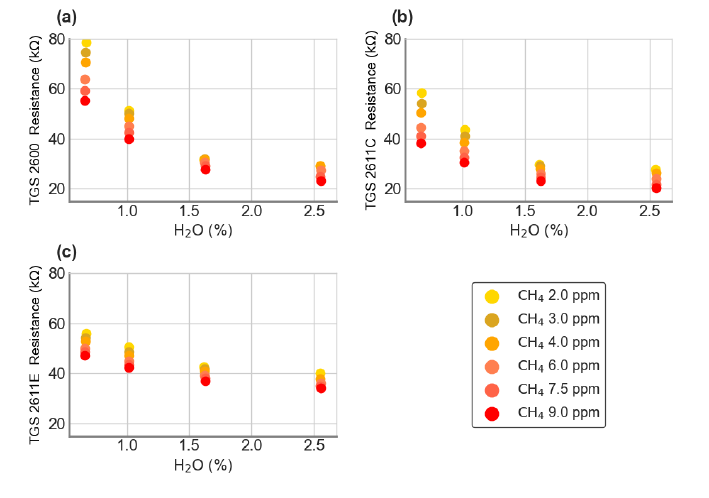
Figure 3. Resistances of Figaro ® sensors ( a ) TGS 2600, ( b ) TGS 2611-C00 and ( c ) TGS 2611-E00 calculated from load voltages corrected for the cross-sensitivity to